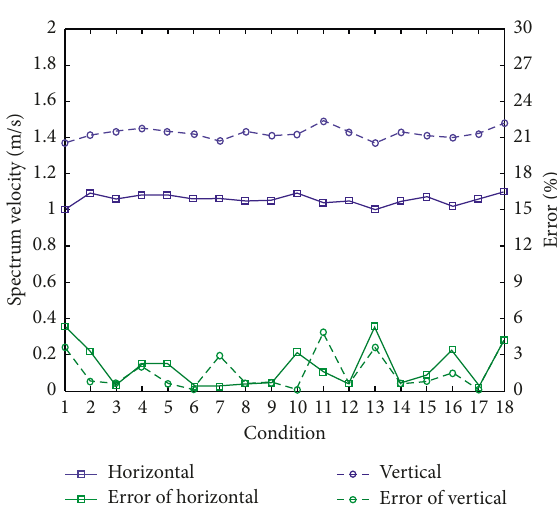
Figure 17: Comparison of the impact response on the starboard side.